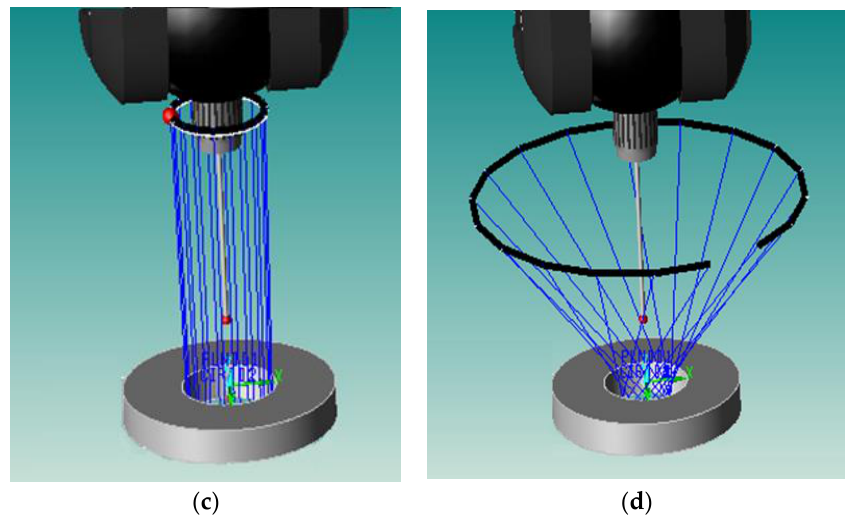
Figure 2. Path control algorithms used during five-axis measurements: ( a ) Guide point (GP); ( b ) guide rail (GR); ( c ) guided curve (GC); and ( d ) fixed tilt and advance (FTAA).